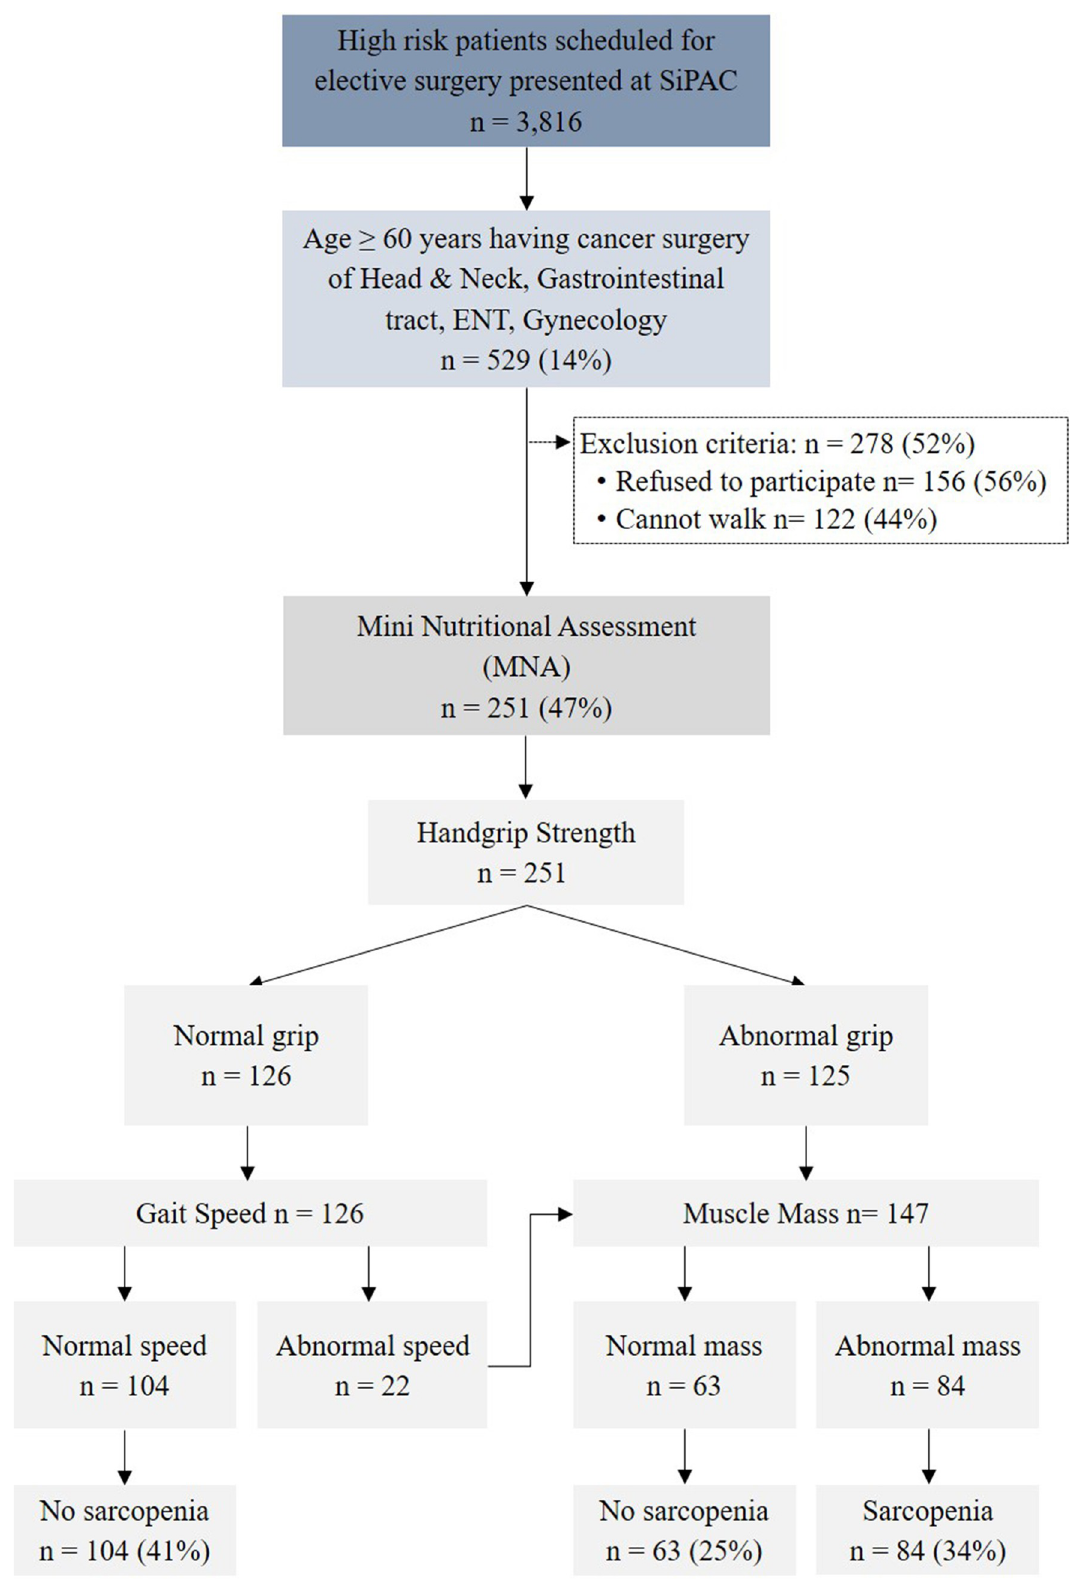
Fig 1. Flow chart of malnutrition and sarcopenia screening. https://doi.org/10.1371/journal.pone.0257672.g001 PLOS ONE | https://doi.org/10.1371/journal.pone.0257672 September 23,